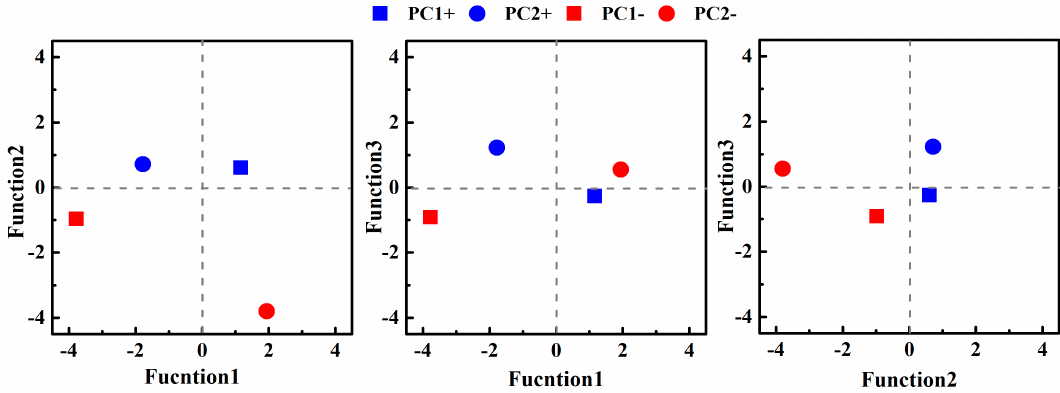
Figure 12. Centroids of each groups got by the PCAs method, corresponding to the first three PDA functions. The farther the vertical projection distance between different groups on a certain PDA function is, the better the PDA function can distinguish them. Table 3. Structure matrix of the three PDA functions for winter wheat (the explained variance by each function is indicated in parentheses; the greater the variance is, the stronger the explanatory